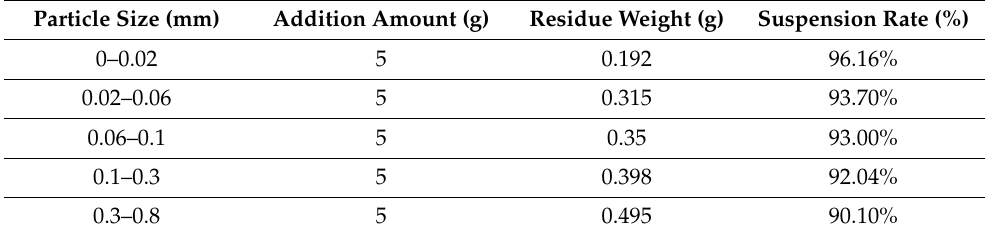
Table 2. Suspension of asphalt